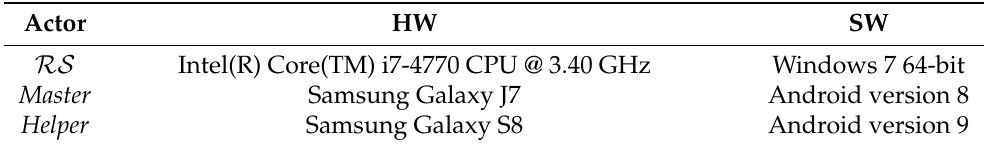
Table 1. Experiment